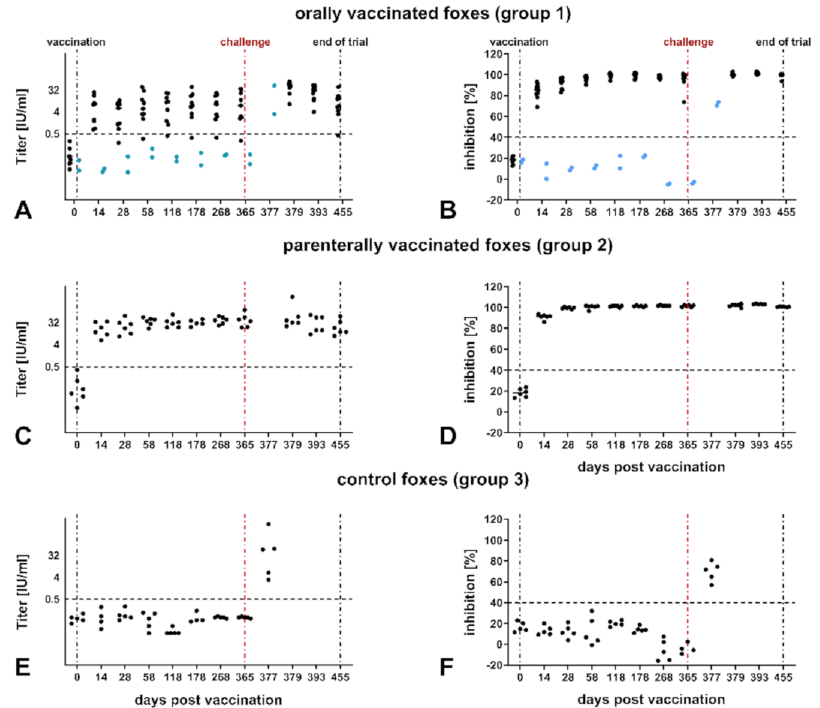
Figure 1. Kinetics of RABV-specific VNA ( A , C , E ) and binding antibodies (PB, ( B , D , F )) after oral and parenteral vaccination with SPBN GASGAS (10 6.6 FFU/mL) and challenge; ( A , B ): orally vaccinated foxes; ( C , D ): parenterally vaccinated foxes (group 2); ( E , F ): non-vaccinated controls. Serological data of animals that succumbed to RABV infection and had to be euthanized 12–14 dpi (Groups 1, 3) were compiled at 377 dpv. Seronegative foxes (No ◦ 34 and 41) in the orally vaccinated group are shown in blue. Vertical dotted lines indicate time point of vaccination (0 dpv), challenge (365 dpv), and termination of the experiment (455 dpv). Horizontal dotted lines show the positivity threshold for RFFIT (0.5 IU/mL) and ELISA (40%